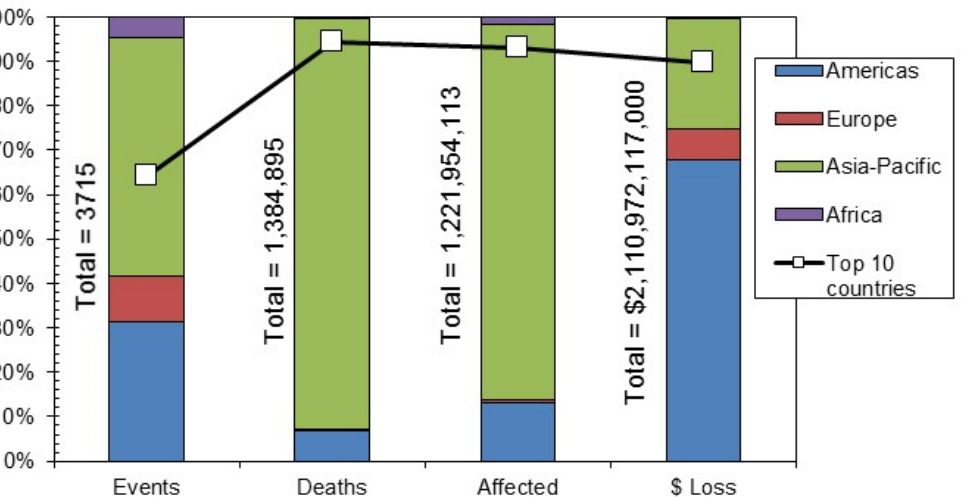
Table 3. Distribution of events, fatalities, affected people, and economic loss in top 10 countries due to meteorological disasters (storms only) from 1900 to 2020 AD. (Data Source: [57]).